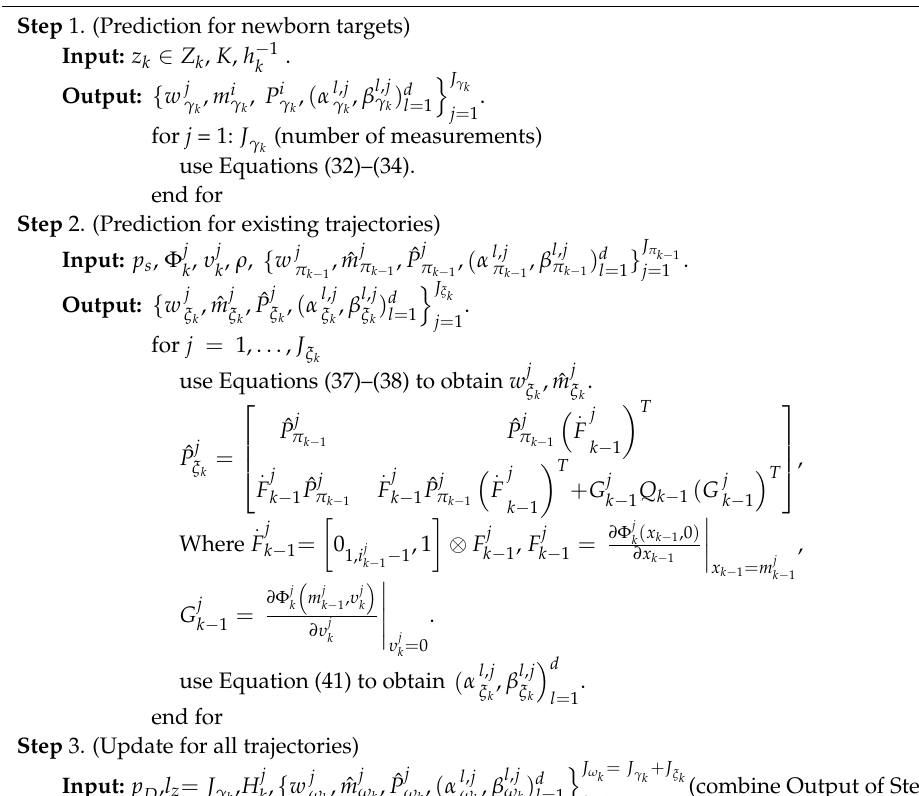
Algorithm 1. Prediction and Update for the AEK-VB-TPHD